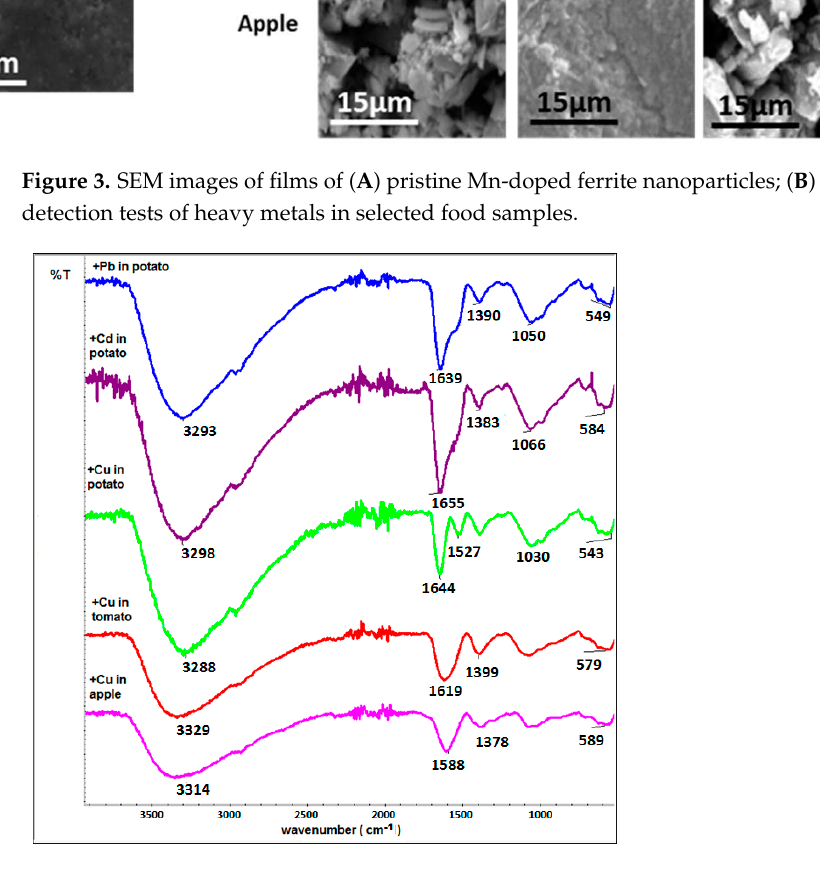
Table 1. Percentage identification of elements in respective juices (columns) and selected modifiers (rows) (LOD—detection limit [36]).